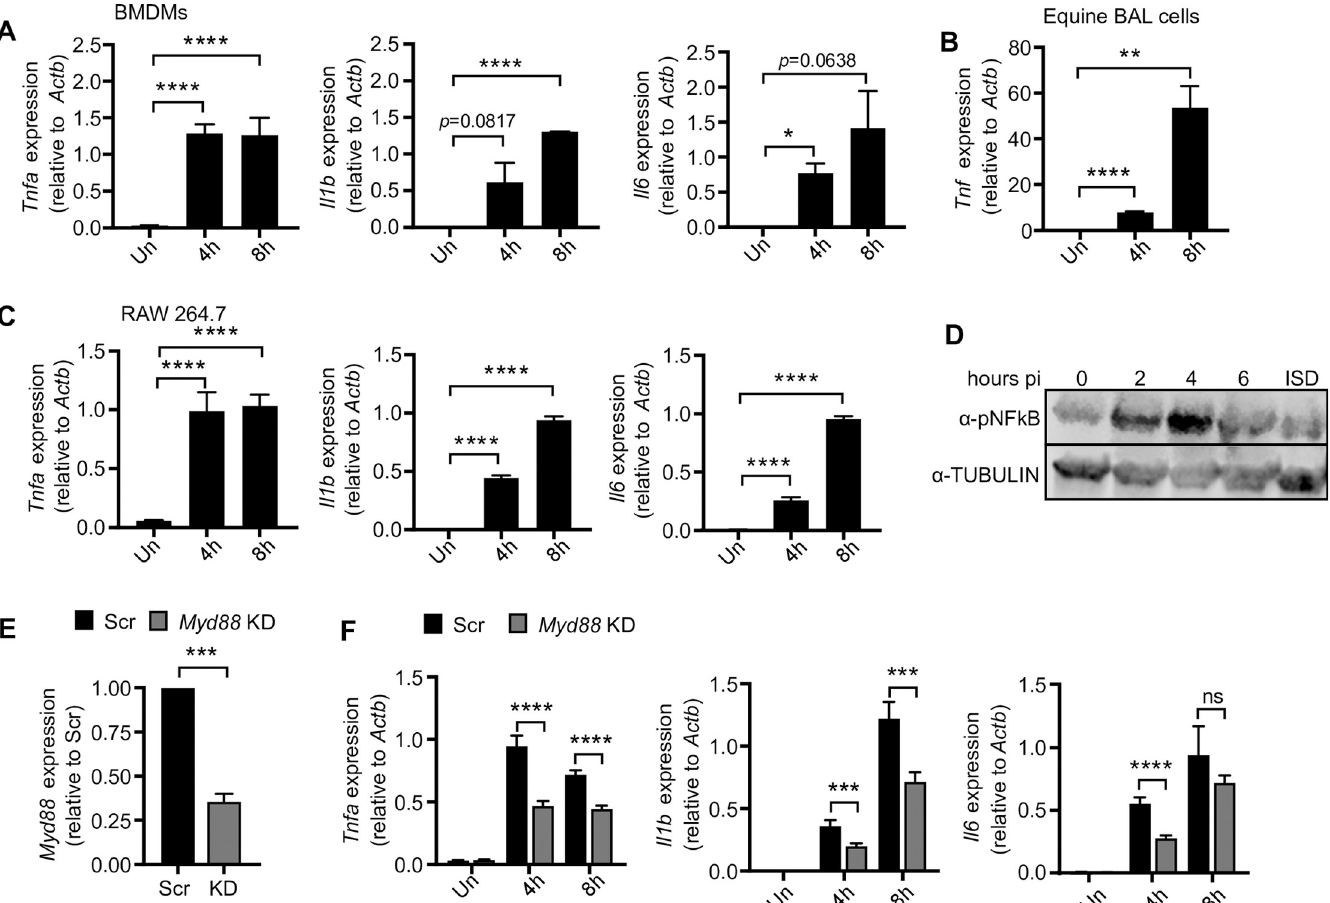
Fig 1. R . equi induces pro-inflammatory cytokine expression during macrophage infection. (A) RT-qPCR of Tnfa , Il1b and Il6 in murine BMDMs at indicated time post R . equi infection. (B) RT-qPCR of Tnf in equine bronchoalveolar cells (BAL) at indicated time post-infection with R . equi . (C) As in (A) but in RAW 264.7 macrophages. (D) Immunoblot of pNF κ B in R-equi -infected or ISD-transfected macrophages, with TUBULIN as a loading control. (E) RT-qPCR of Myd88 expression in RAW 264.7 Myd88 KD cells relative to Scr control. (F) RT-qPCR of Tnfa , Il1b or Il6 in R . equi -infected Myd88 KD macrophages. All RT-qPCRs are the mean of 3 replicates ± SD, n = 3 and are representative of at least 2 independent experiments. Statistical significance was determined using Students’ t-test. � p < 0.05, �� p < 0.01, ��� p < 0.001, ���� p < 0.0001, ns = not significant.